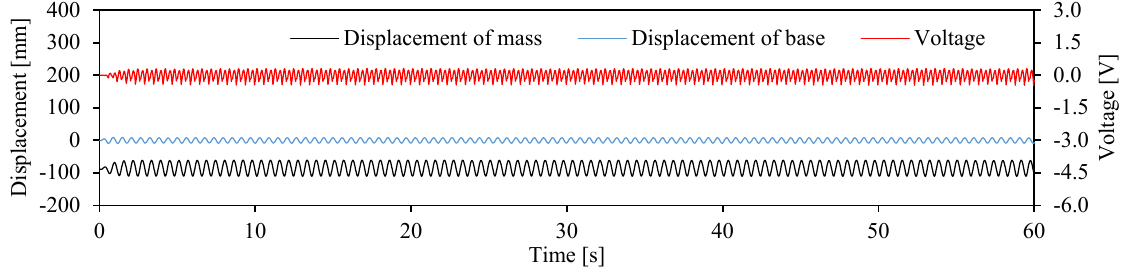
deviations of the vibration displacement of the mass block and support point were 12.03